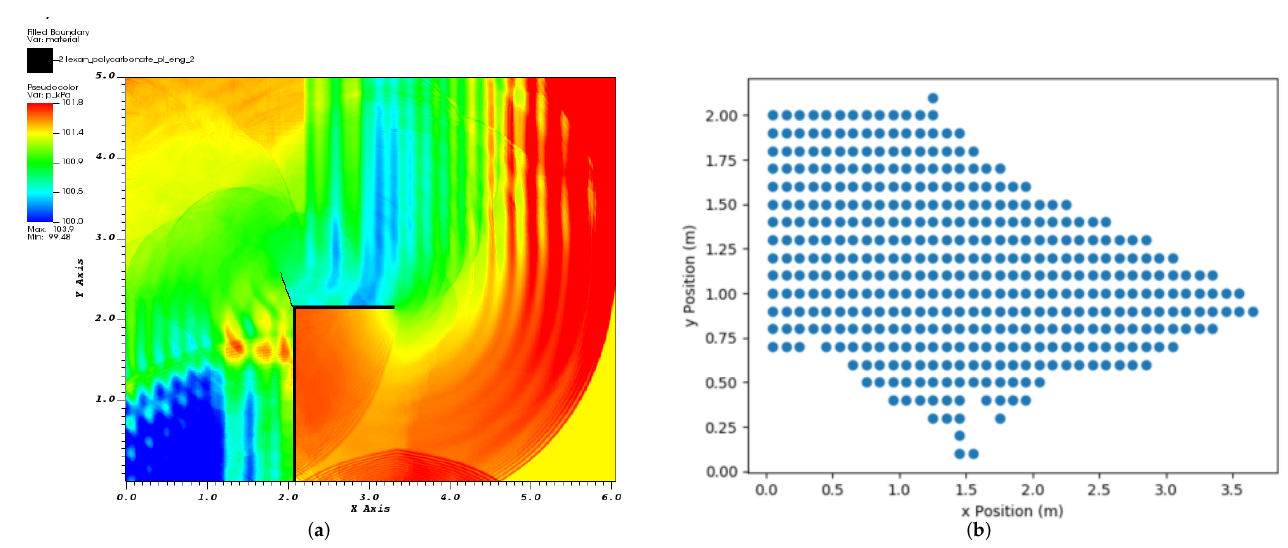
Figure 15. Results from a plane strain analysis of a ‘deep-roof’ type mitigation barrier loaded by a wave generated from 0.45359 kg of TNT at approximately 36.576 m. ( a ) A snapshot of the wave reflecting over the barrier. The color gradient is set so that max (red) values are above the 0.4516 kPa overpressure threshold. ( b ) The “bubble” behind the barrier for which max overpressure was beneath 0.4516